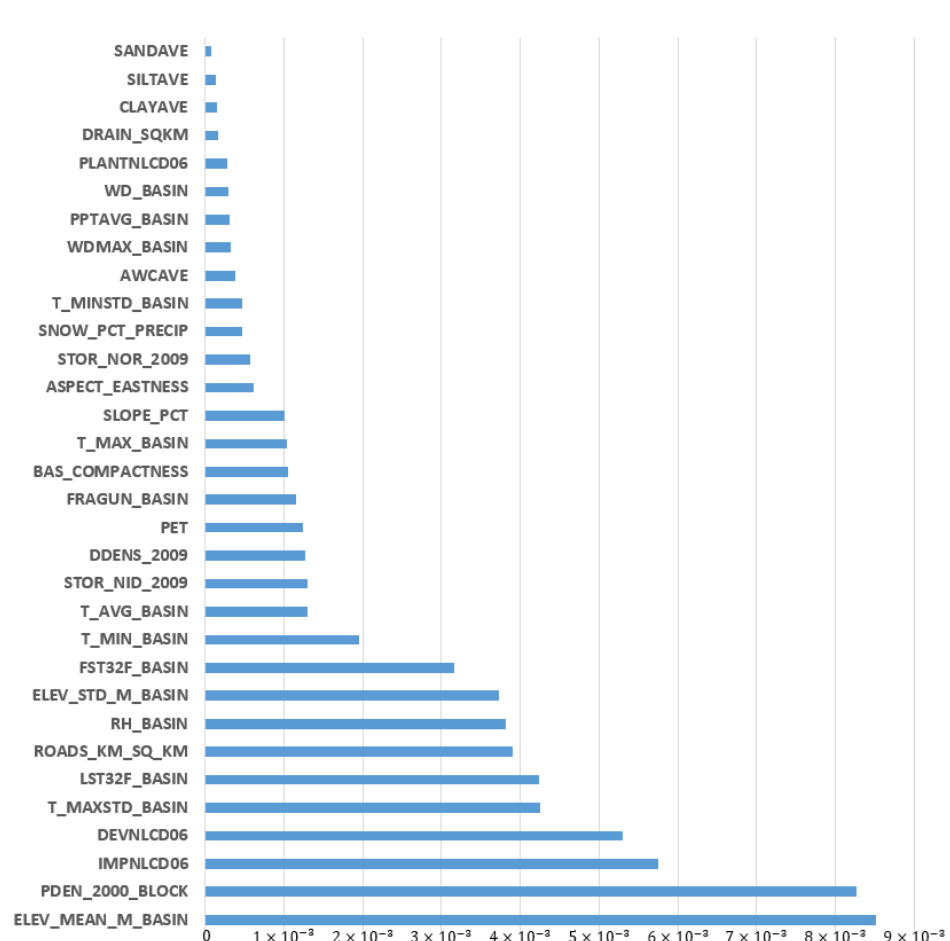
Figure 6. Predictor variables of the shape parameters (with associated importance) for Central Lowland. Description of predictor variables is provided in Appendix A.